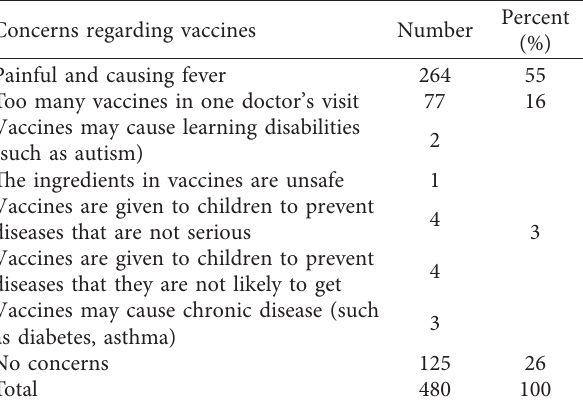
Table 4: Concerns regarding vaccines reported by the surveyed parents.